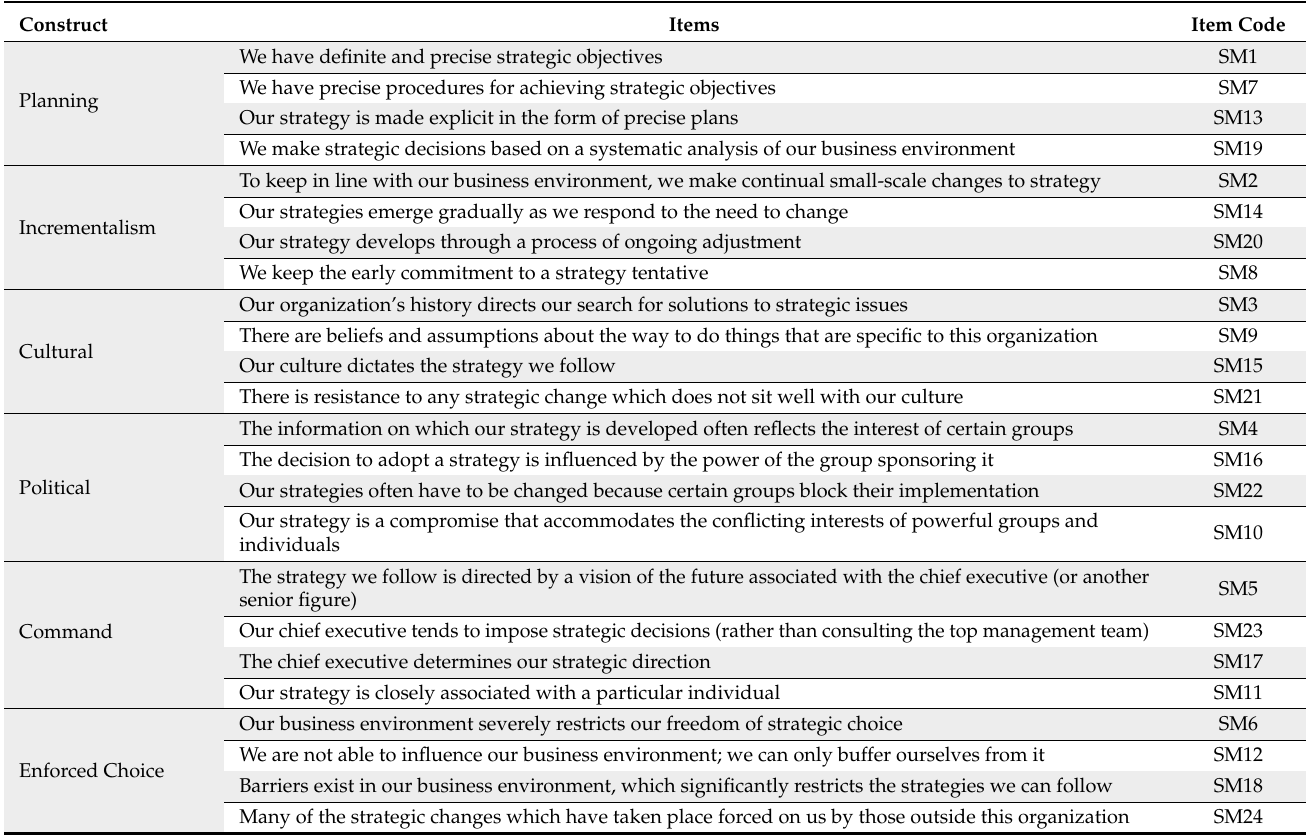
Table 2. Survey used in this